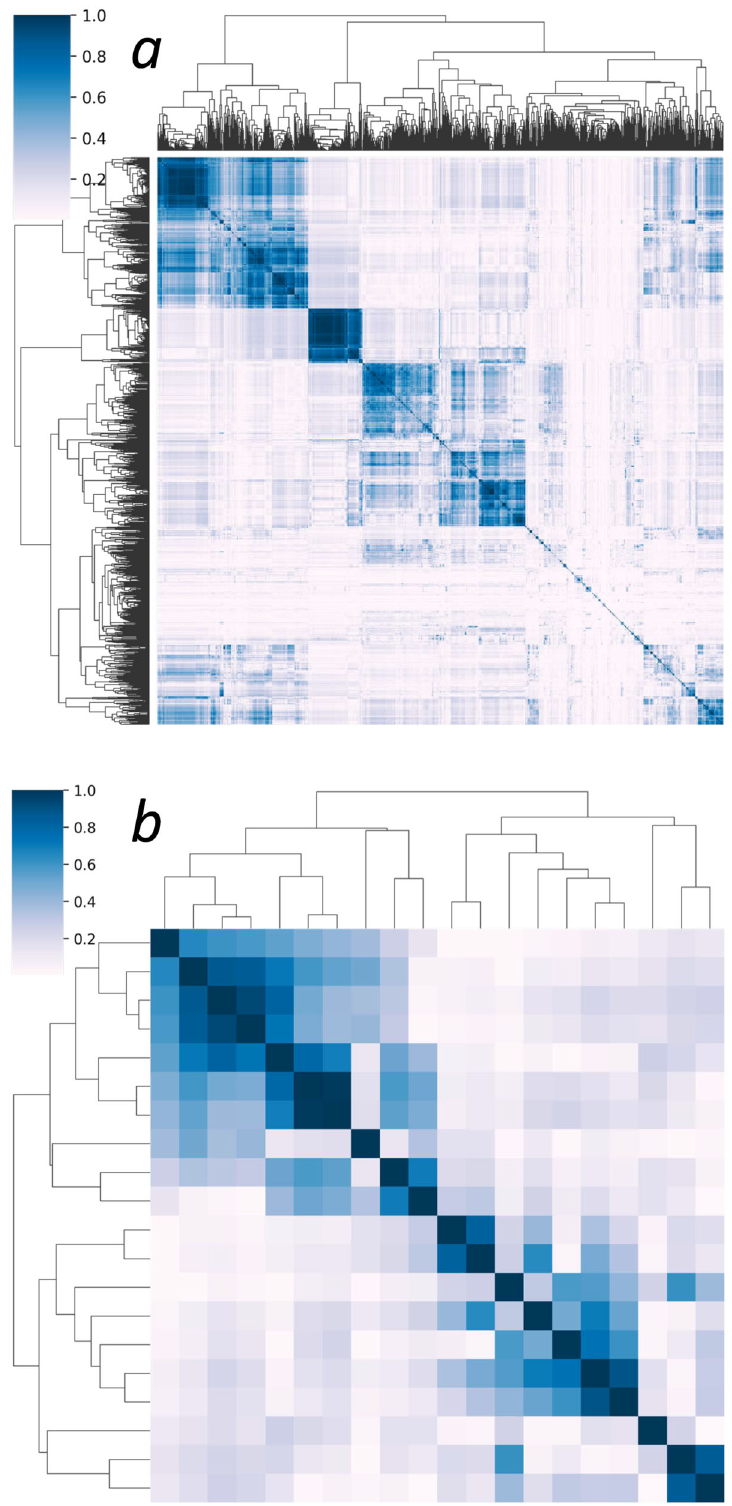
Fig. 2 Heat maps of the absolute values of the correlation coef fi cients between results of operations. a Correlations between all 3555 candidate algorithmic operations. b Correlations between 20 cluster medoids. The reduced feature set explains 81% of the variance in the full